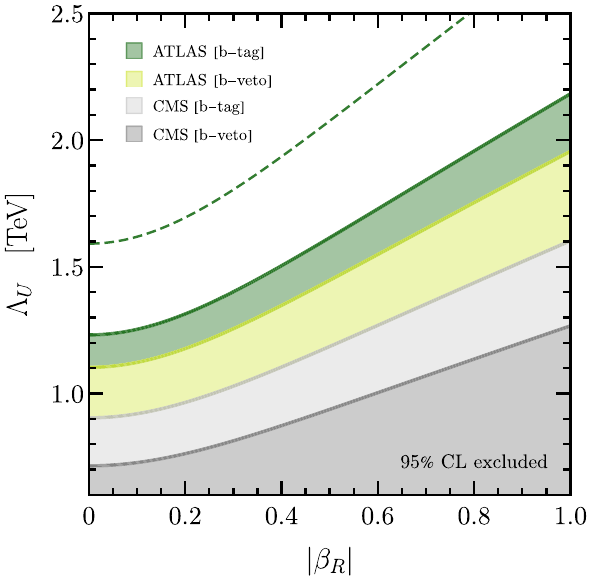
Fig. 2 High- p T constraints on the U 1 model parameters β R and (cid:12) U derived from the pp → τ ¯ τ searches by CMS [36] (gray) and ATLAS [39](green)inthe b -tagand b -vetochannels.Thefunctionaldependence is extracted using the HighPT package [63,77] and rescaled to the results presented in Ref. [34]. The shaded regions correspond to the excluded parameter space at 95% CL. The solid lines correspond to the constraints obtained using LHC run-II ( ∼ 140fb − 1 ) data, whereas the dashedlinedisplaystheprojectionsforLHC’shighluminosityphase ( ∼ 3ab − 1 ) for the ATLAS b -tag search